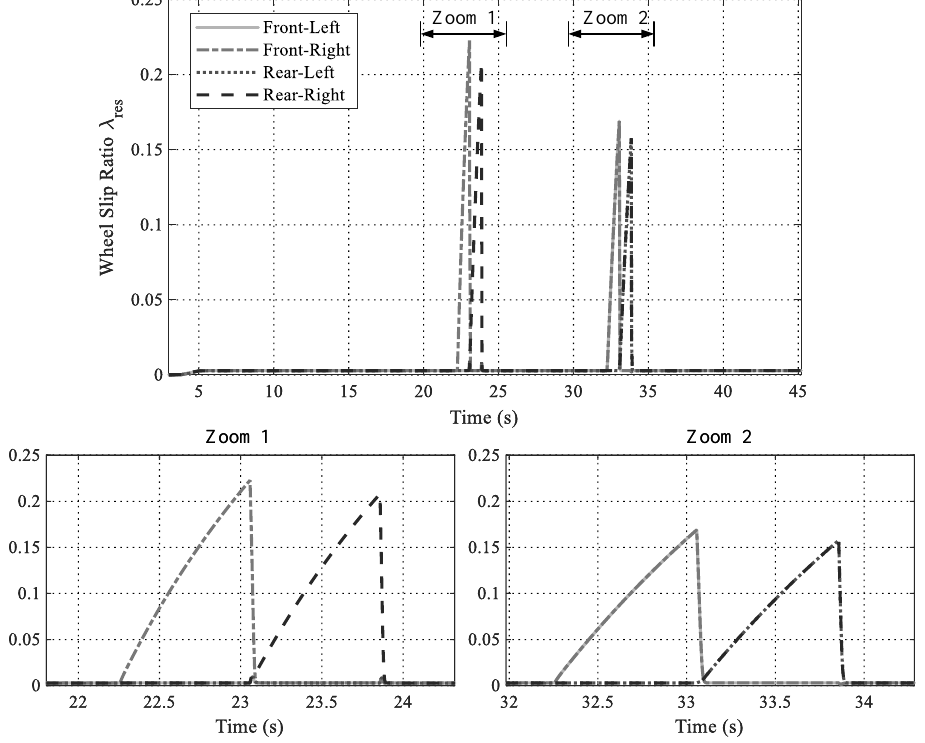
Figure 18. Slip-ratio at Wheels for Scenario 2 and 3. The Zoom 1 is associated with Scenario 2 and the Zoom 2 is for Scenario